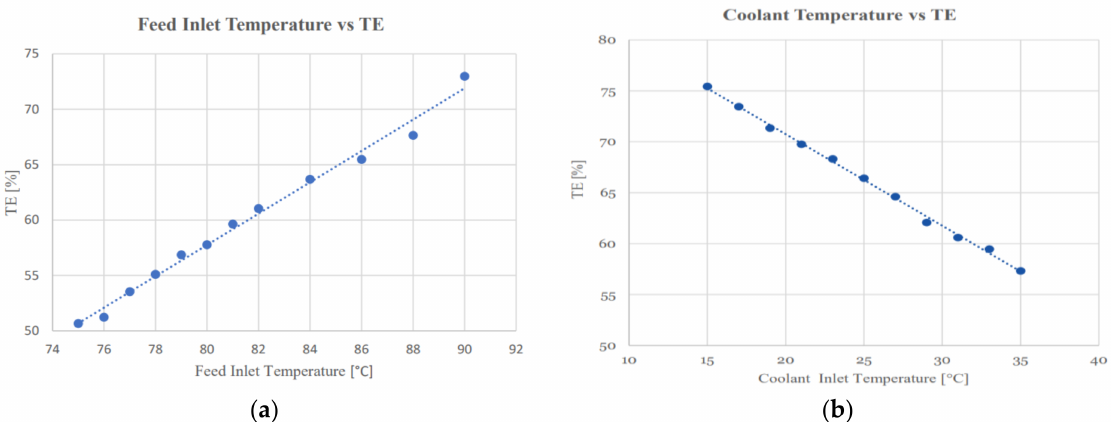
Figure 6. Effects on increasing feed/coolant inlet temperature versus TE: ( a ) Effects on increasing feed inlet temperature vs. resulting SEC. ( b ) Effects on increasing coolant inlet temperature vs. resulting